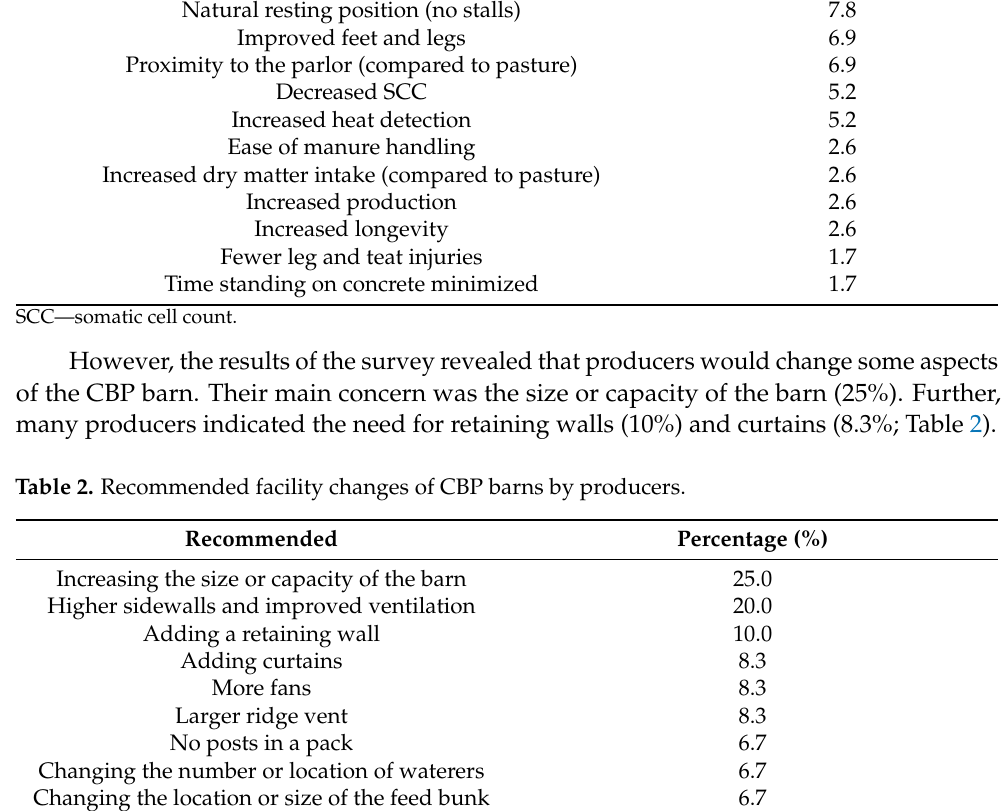
Table 1. Producer-cited benefits of 42 CBP barns.